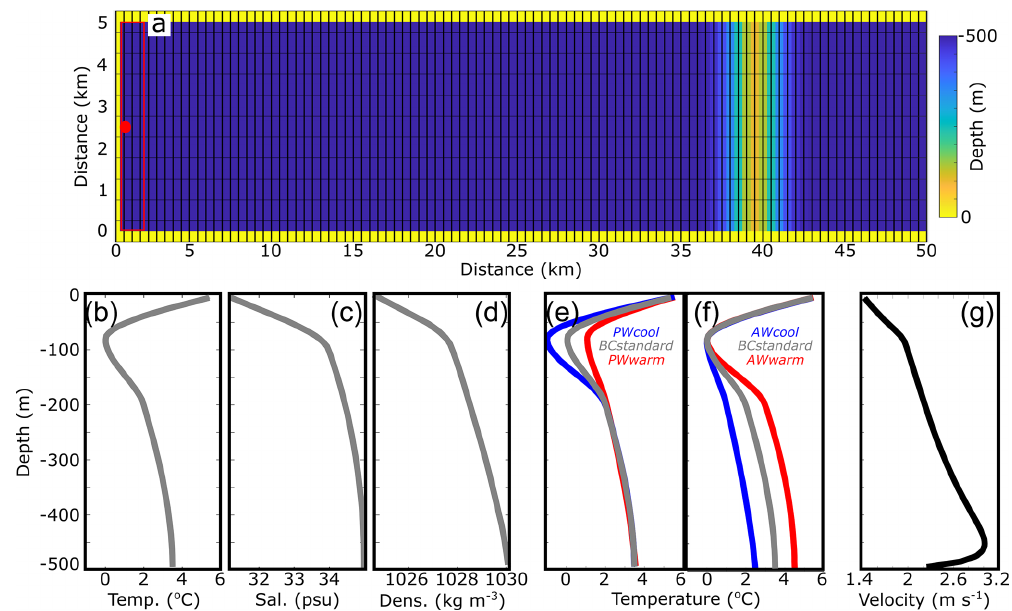
Figure 1. Model domain and boundary conditions. (a) Plan view of model bathymetry with sill, with the ice wall at the left end of the domain (0km) and the open boundary on the right. Hatching indicates model resolution (note that grid cells are 500m × 500m in the horizontal). The red dot marks the location of subglacial discharge injection and the red box indicates the region from which steady-state glacier-adjacent water properties were extracted. In simulations without a sill, the domain is uniformly 500m deep. Vertical profiles of (b) temperature, (c) salinity and (d) density with BCstandard . (e) Temperature profiles with varying PW temperature. (f) Temperature profiles with varying AW temperature. (g) Example of plume vertical velocity from the simulation with iceberg scenario 5, 500m 3 s − 1 subglacial discharge and BCstandard boundary